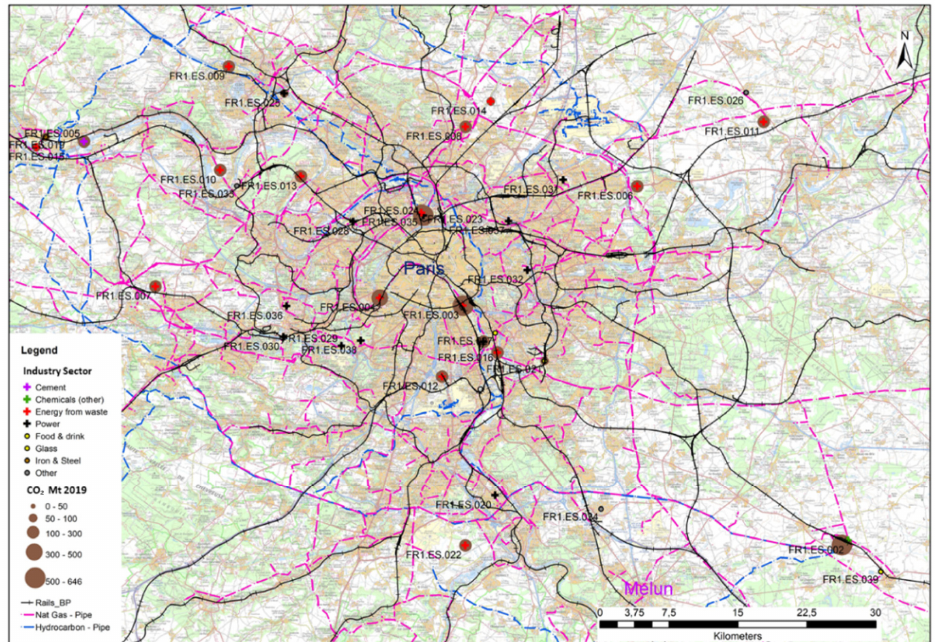
Figure 4. Geographical location of emission sources of the Paris Basin region. Color of symbol indicates the industrial sector and the size of symbols (in brown) the CO 2 emission in Mt in 2019 (data from [20]). The railways and existing natural gas and hydrocarbon pipelines are also indicated in the map (pipeline data from: GRTgaz and Data Gouv.).